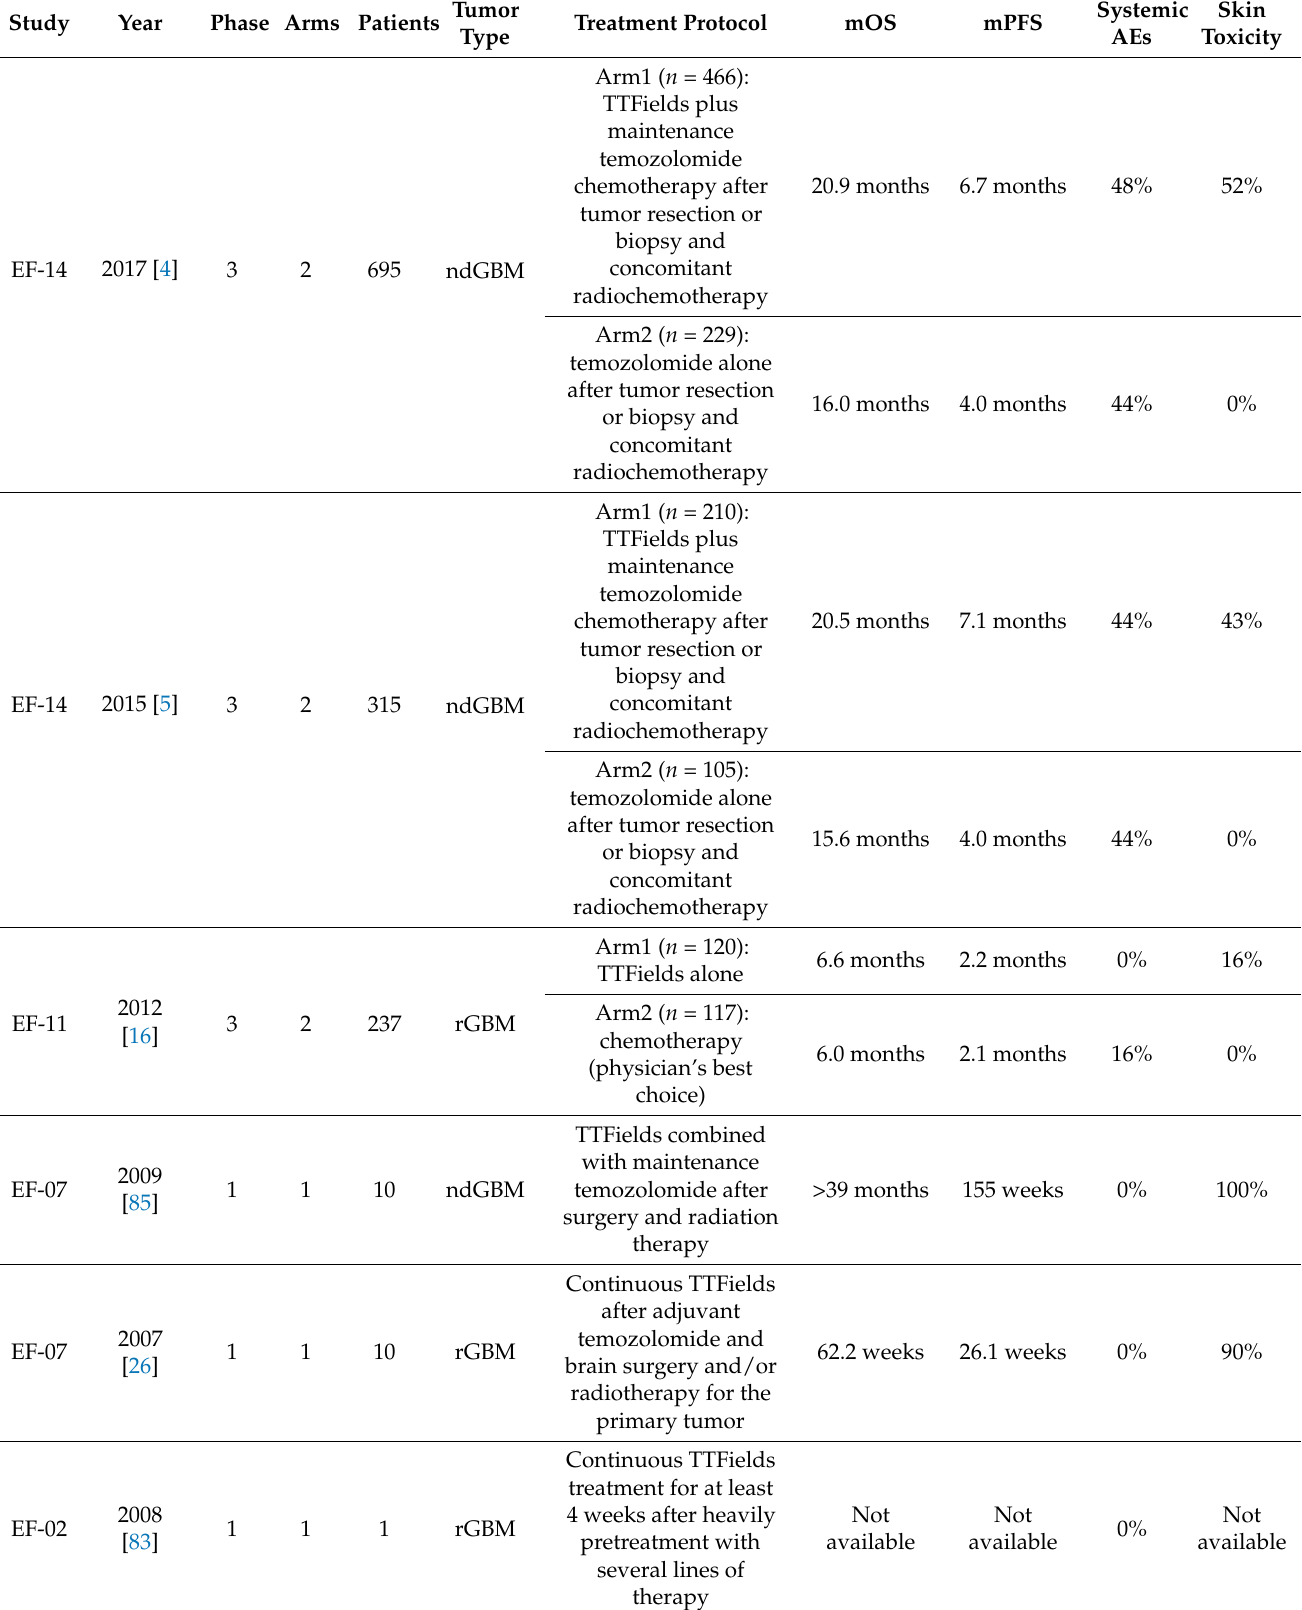
Table 1. Landmark clinical trials of TTFields in treating